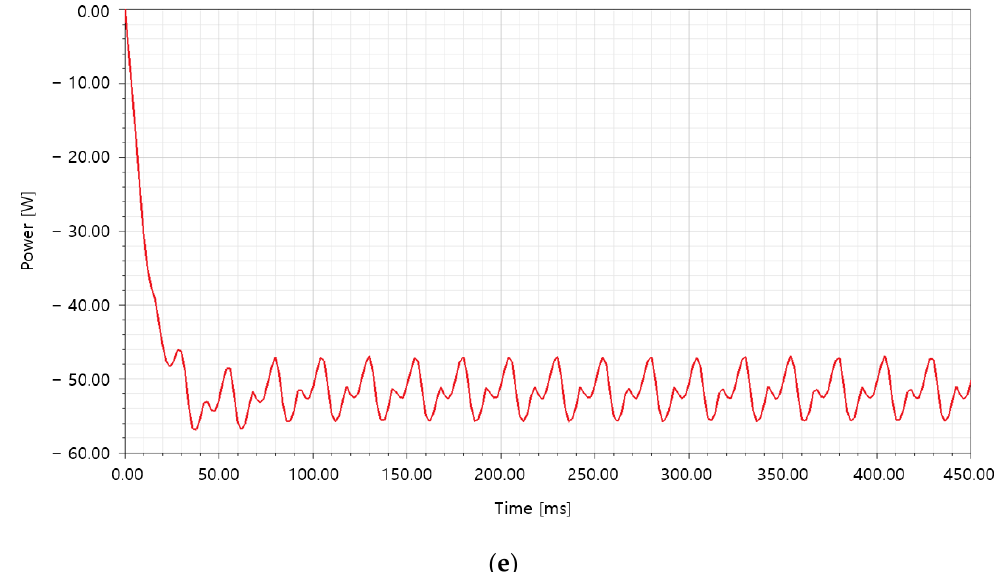
Figure 19. Optimal design results: ( a ) current of optimal model; ( b ) voltage of optimal model; ( c ) magnetic flux line; ( d ) magnetic flux density; ( e ) power. Table 7. Power amount of the initial model and optimal model.